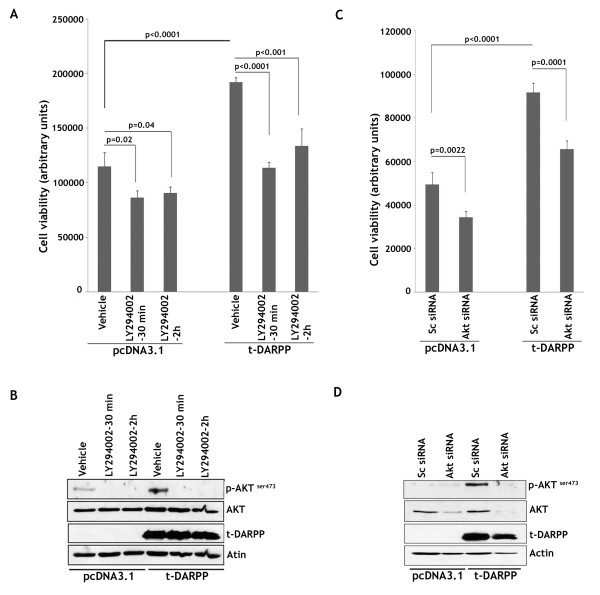
t-DARPP-induced cell growth is dependent on PI3K/AKT signaling pathway. A, MCF-7 cells stably expressing t-DARPP or pcDNA3.1 vector were treated with either vehicle or 40 μM of LY294002 for 30 min or 2 h. The cells were washed with PBS and grown for 24 h, and then subjected to Cell-Titer-Glo Luminescent Cell Viability Assay. The results indicated a significant increase of cell growth in t-DARPP-expressing cells relative to control cells after treatment with vehicle. This growth increase was almost completely abrogated after treatment with LY294002. B, MCF-7/t-DARPP and MCF-7/pcDNA3.1 cells were treated with vehicle and 40 μM of LY294002 for 30 min or 2 h, and then grown for 24 h. Protein extracts were subjected to western blot analysis of t-DARPP, p-AKTser473, and AKT. The results showed that p-AKTser473 protein level was significantly higher in t-DARPP-expressing cells than control cells, and treatment with LY294002 blocked phosphorylation of AKTser473 in all cells. C, MCF-7/t-DARPP and MCF-7/pcDNA3.1 cells were transfected with scrambled siRNA or Akt siRNA and grown for 48 h. The cells were then subjected to Cell-Titer-Glo Luminescent Cell Viability Assay. The results indicated a significant increase of cell growth in t-DARPP-expressing cells relative to control cells after transfection with scrambled siRNA. This growth increase was partially abrogated after transfection with Akt siRNA. D, MCF-7/t-DARPP and MCF-7/pcDNA3.1 cells were transfected with scrambled siRNA or Akt siRNA and cultured for 48 h. Protein extracts were analyzed by Western blot for p-AKTser473, AKT, t-DARPP, and β-actin. Results are representative of four experiments and shown as the mean ± SD. Significance of difference was calculated using Student's t test analysis.